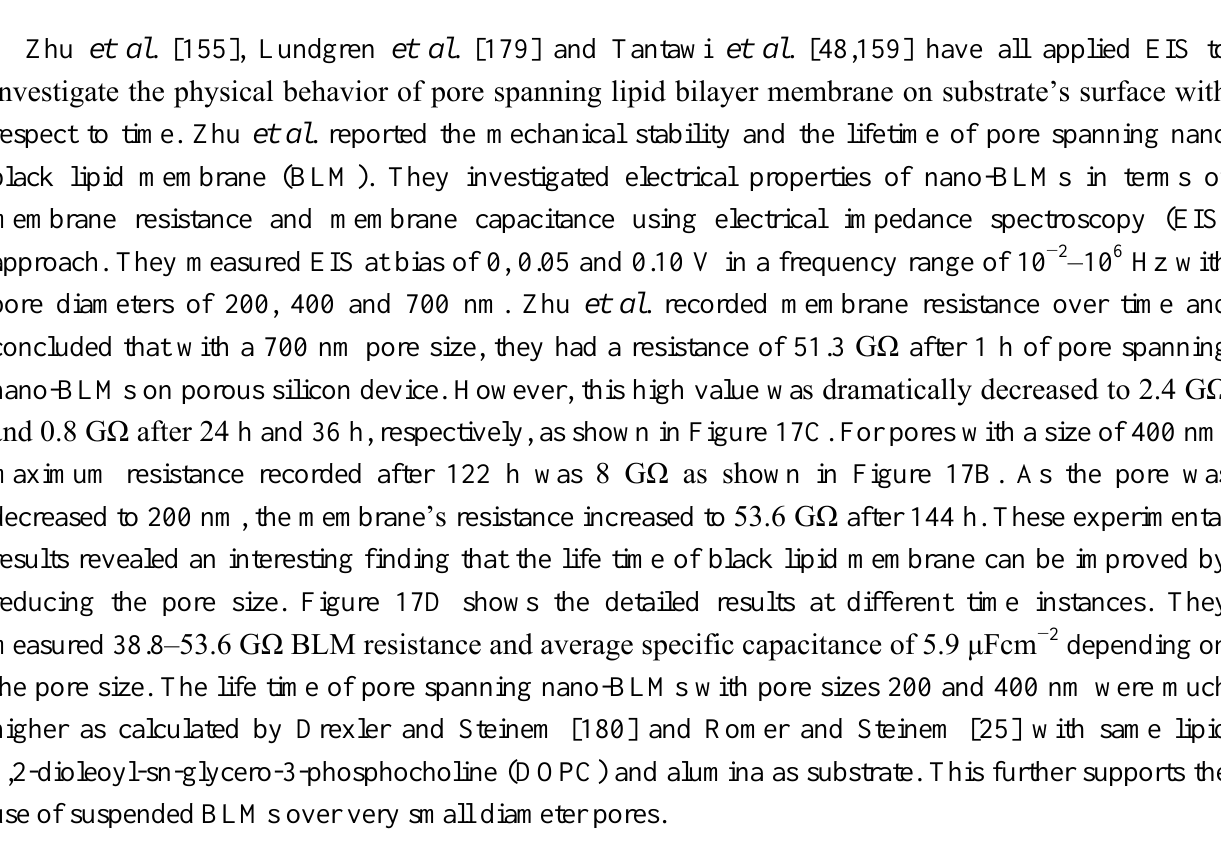
Figure 17. Electrochemical impedance spectroscopy (EI)S of pore-spanning nano-BLMs on silicon substrate with diameter ( A ) 200 nm; ( B ) 400 nm; ( C ) 700 nm at different time periods; ( D ) Membrane resistance at different time periods with different nano pores in a frequency range of 10 −2 –10 6 Hz. Reprinted with permission from Langmuir